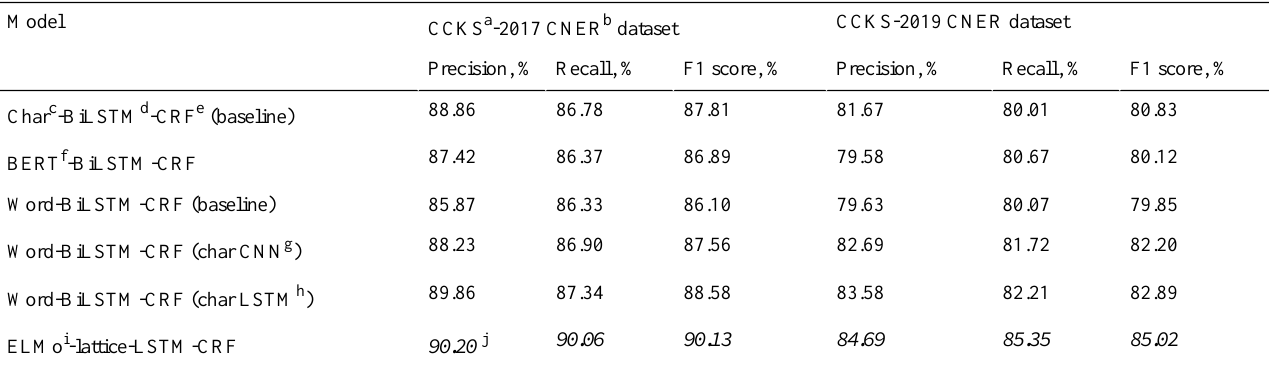
Table 4. Results of various models with different architectures on two